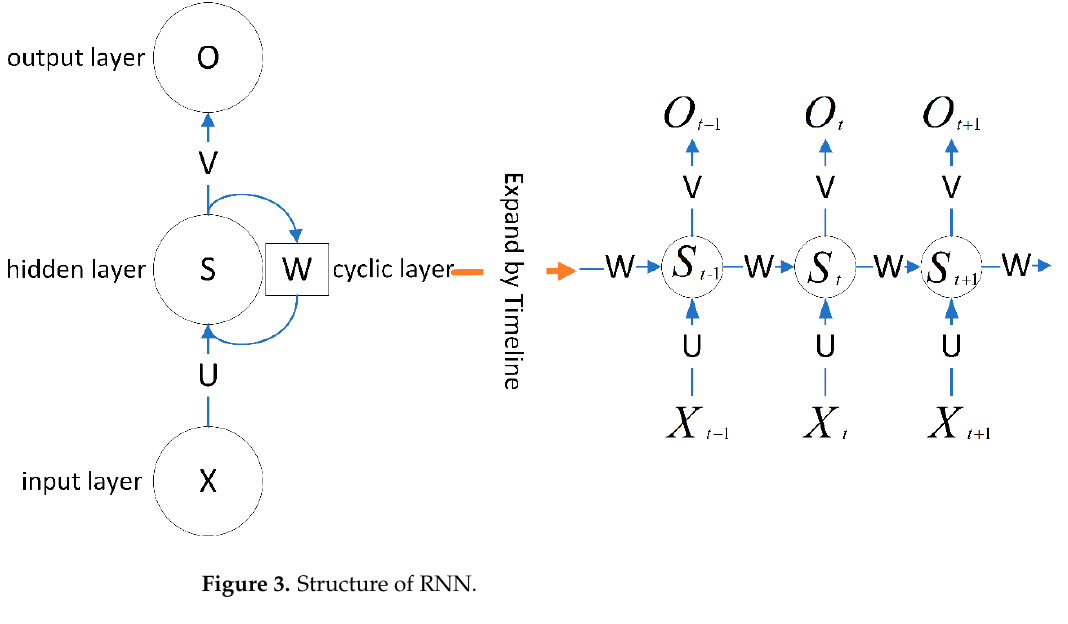
Figure 3. Structure of